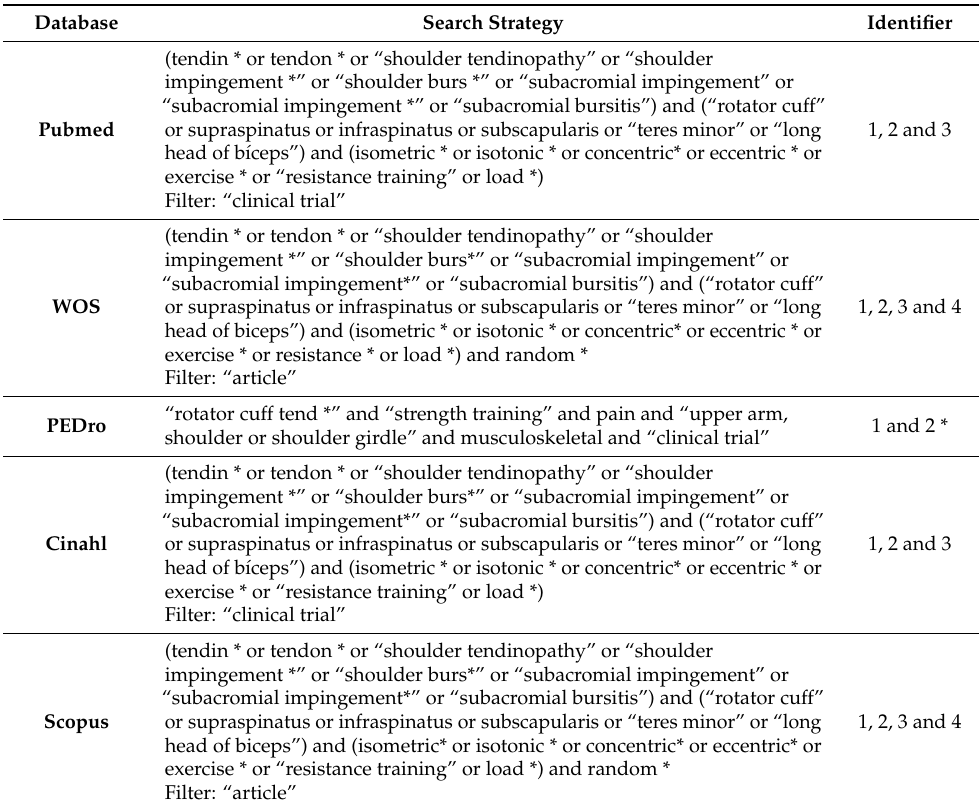
Table A2. Search strategy in the different